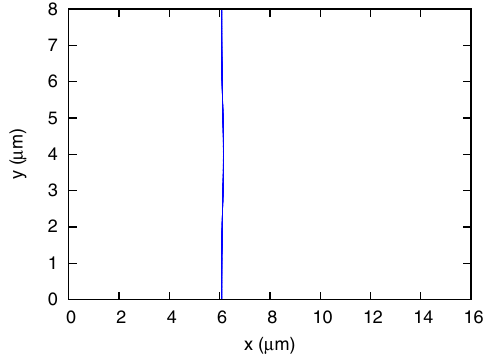
FIG. 9. Proton layer after the interaction with single laser pulse ¼ 0 : 6 ) introduced at the left boundary. ( (cid:1) 1